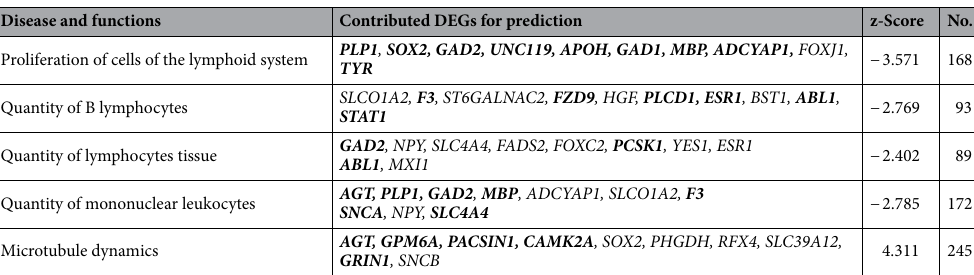
Table 5. Top disease and biological function predicted by IPA to be associated with NDV infection. Bold italic and italic text indicates upregulated and downregulated DEGs respectively. Genes are sorted ascendingly from left to right based on their fold change. No. means the number of DEGs in our data contributed to disease production.